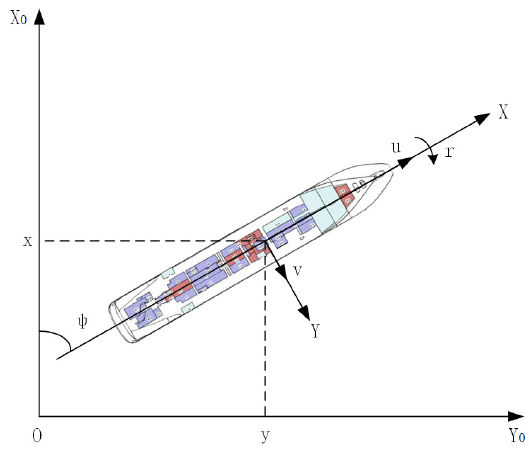
Figure 1. Simplified vessel motion coordinate